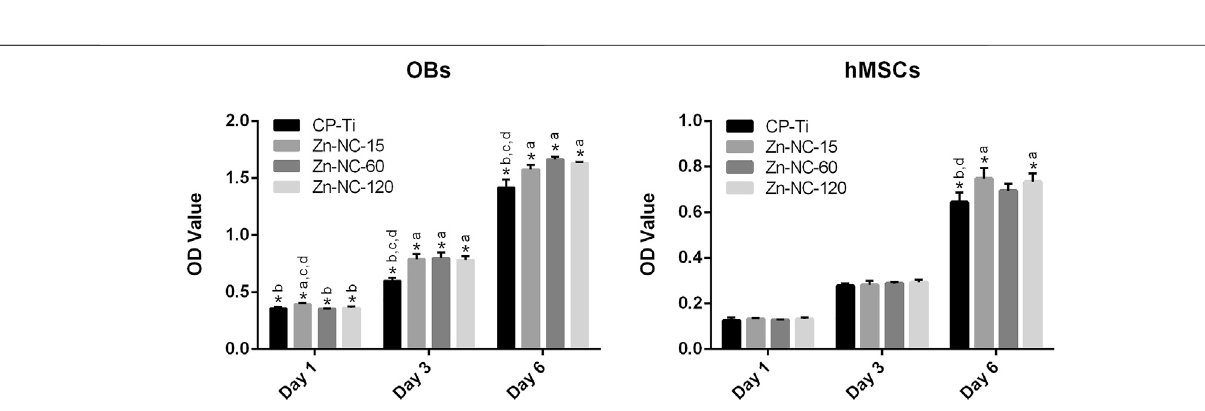
FIGURE9| Proliferation ofOBsand hMSCs cultured for1, 3, and 6 days ondifferentsurfaces(n (cid:2) 3). * p < 0.05; a P < 0.05 vs. CP-Ti; b P < 0.05 vs. Zn-NC-15; c P < 0.05 vs. Zn-NC-60; d P < 0.05 vs. Zn-NC-120.